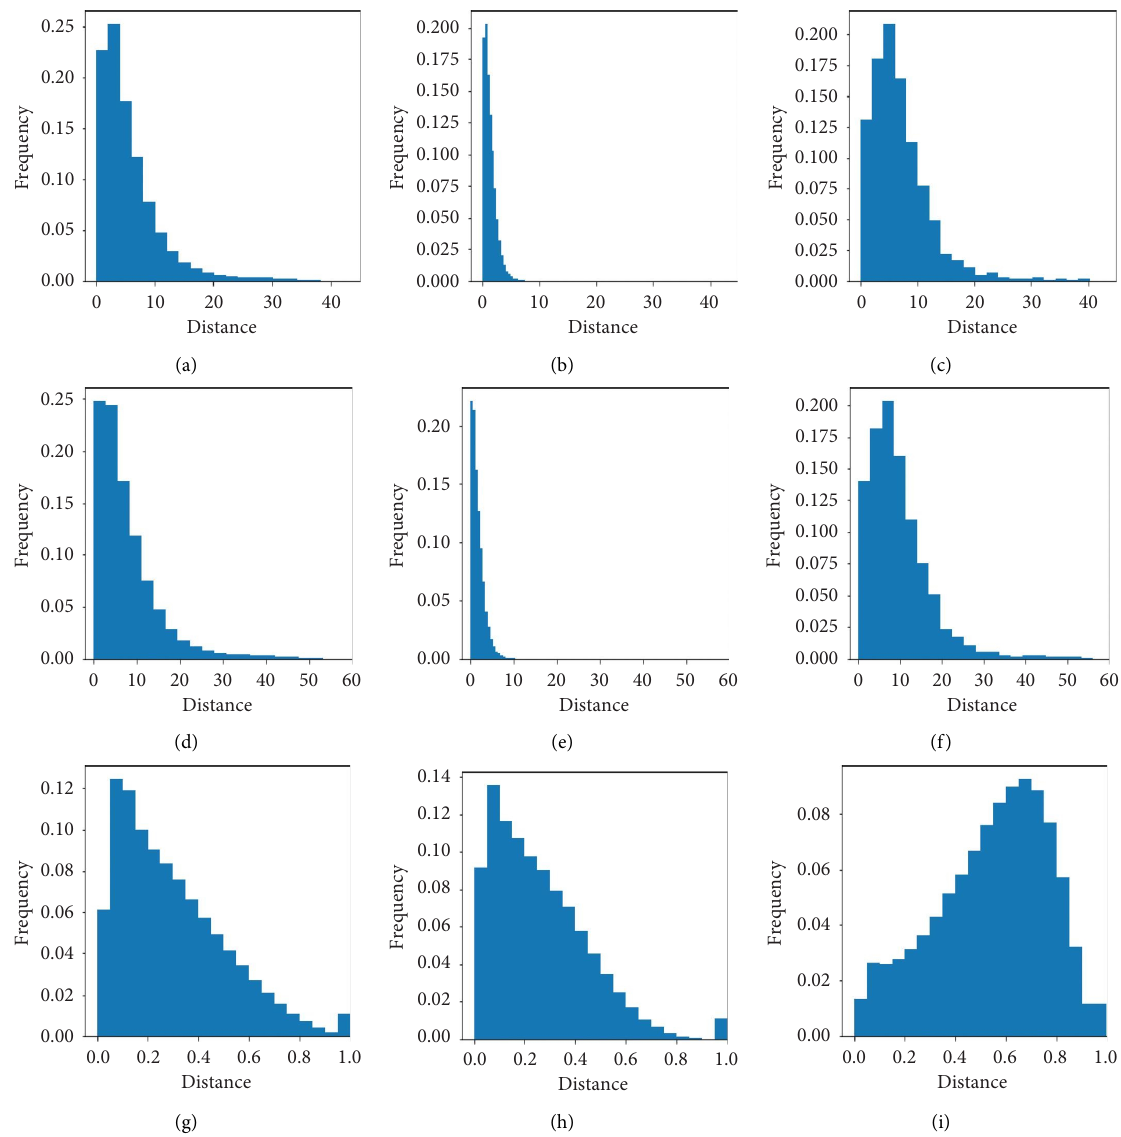
Figure 5: Histograms of diferent distances for the indicator proposed by Huang et al. f h , where x -label denotes the distance between two feature vectors, and y -label denotes the frequency of the corresponding distance values in all the calculated distances. First column: distances between windshear cases. Second column: distances between non-windshear cases. Tird column: distances between windshear and non- windshear cases. Top row: histograms of the Euclidean distance. Second row: histograms of the city block distance. Bottom row: histograms of the Bray–Curtis distance.